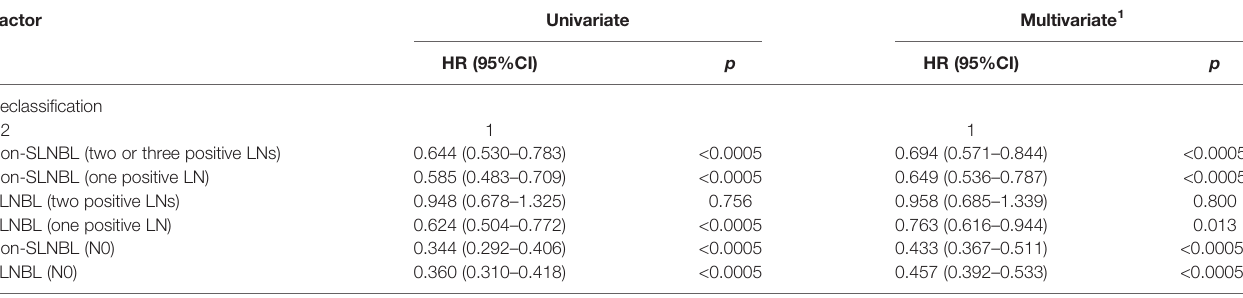
TABLE 1 | Prognostic factor of nodal burden according to lymph nodes analyzed ( n = 63,074).